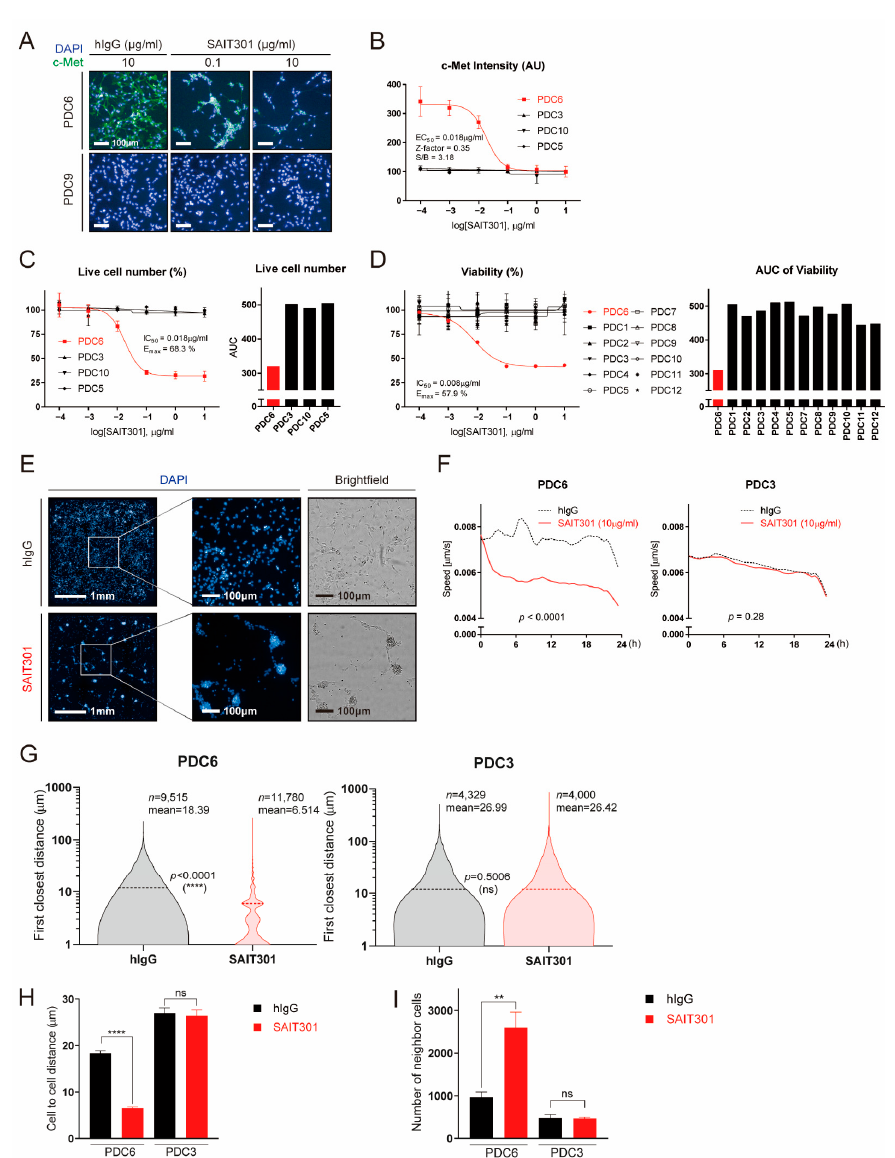
Figure 2. Multi-dimensional high-content analyses demonstrate the effect of SAIT301 on glioblastoma patient-derived cells. ( A ) Representative images of c-Met (green) and DAPI (4 ′ ,6-diamidino-2-phenylindole) (blue) in PDC6 and PDC9 cells treated with control IgG (10 µ g/mL), SAIT301 (0.1 µ g/mL, 10 µ g/mL) for 24 h are shown. ( B ) DRC (Dose Response Curve) graph of c-Met im- munofluorescence intensity measurements in indicated cells treated with SAIT301 (0.0001–10 µ g/mL) for 24 h. ( C , D ) A DRC of cell viability in response to SAIT301 (0.0001–10 µ g/mL) for 7 days was evaluated by either image-based high-content analysis (cell number counting, C ) or ATP-based assay ( D ). IC50 and the maximal efficacy (Emax) are indicated in the graph. Data represent mean ( n = 3) and SD = 1 error. AUC values are also shown on the right sides. ( E ) Representative images of DAPI (10 × ) and their magnified images (40 × ) of PDC6 cells treated with or without SAIT301 (10 µ g/mL) for 24 h are shown. Brightfield images are on the right sides. ( F ) The speed of cell movement was calculated by analyzing real-time cell images taken every 30 min for 24 h. PDC3 data are shown for comparison. ( G ) PDC3 and PDC6 cells treated with either control hIgG (Human Immunoglobulin G) (10 µ g/mL) or SAIT301 (10 µ g/mL) were analyzed at the single-cell level. The first closest distance (pixel) of single cells is shown as violin plots. Cell numbers used in analysis are indicated with the mean value and p -value. ( H ) Mean value of cell-to-cell distance ( µ m) and ( I ) number of neighbor cells (fold change) (****: p < 0.0001, **: p < 0.01, ns: p > 0.05, not